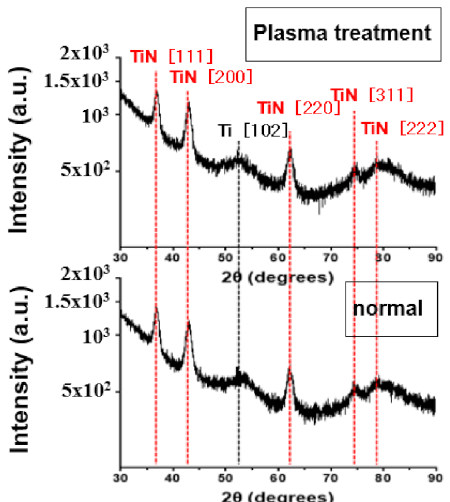
Figure 11. XRD images of plasma treatment of TiN thin films deposited at a deposition temperature of 600 ◦